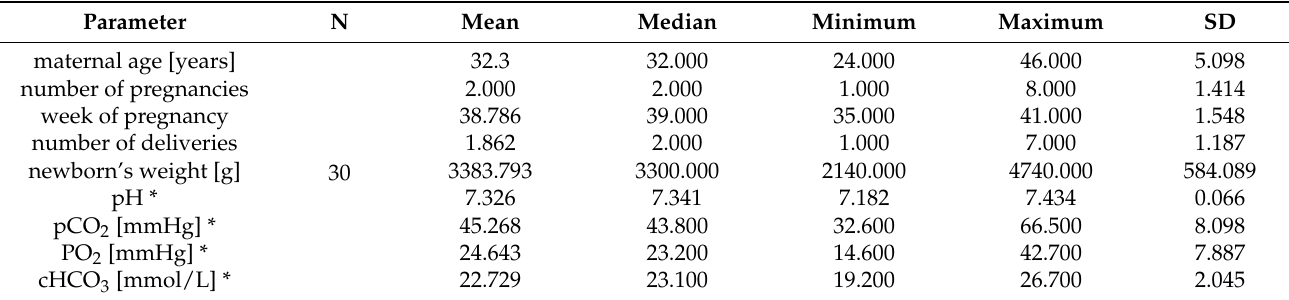
Table 1. Statistics of pregnancy related